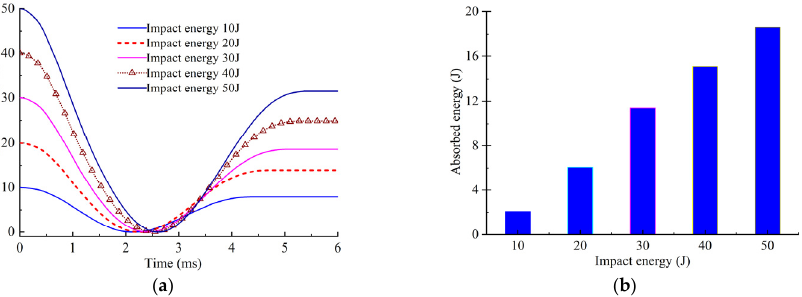
impact energy. The location of the fiber damage and matrix damage is the same as that in